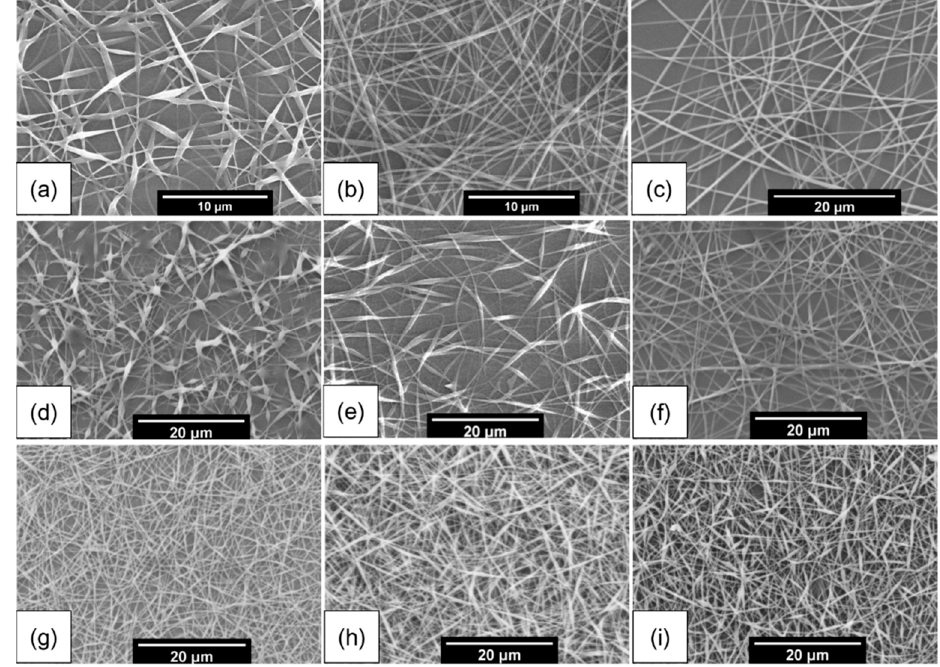
Figure 3. Scanning electron micrographs. Nanofibers produced using various pure PVA solutions (parameters 60 °C, 100 rpm for 60 min; all other conditions are constant): ( a ) 6; ( b ) 8; and ( c ) 10 wt %.